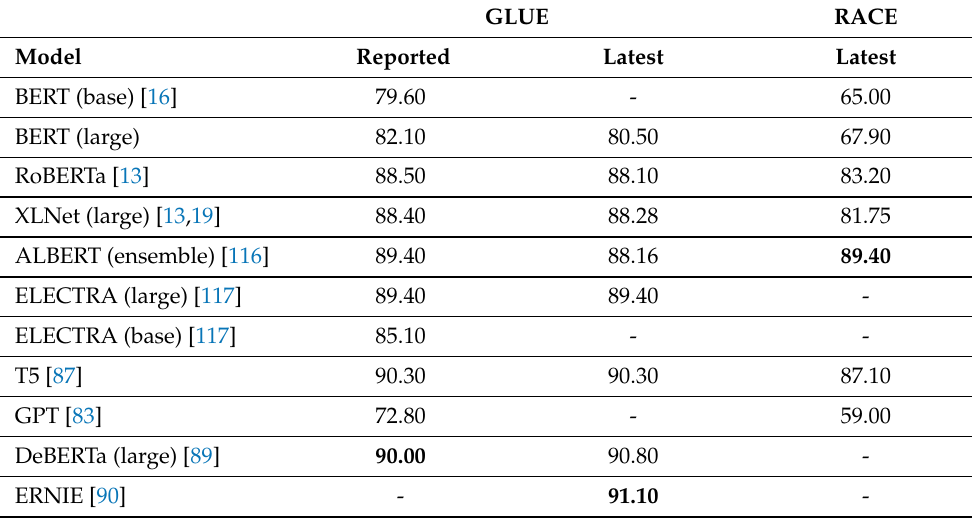
Table 6. GLUE and RACE score updated to latest results (best ones in